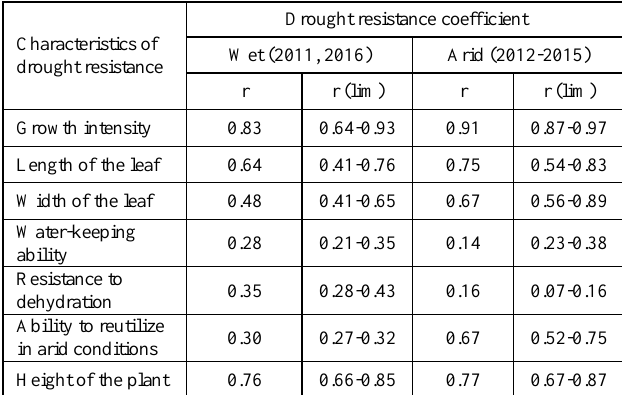
Table 5. Dependence of green mass productivity on the features of drought resistance of lovage samples in the years with different levels of moisture